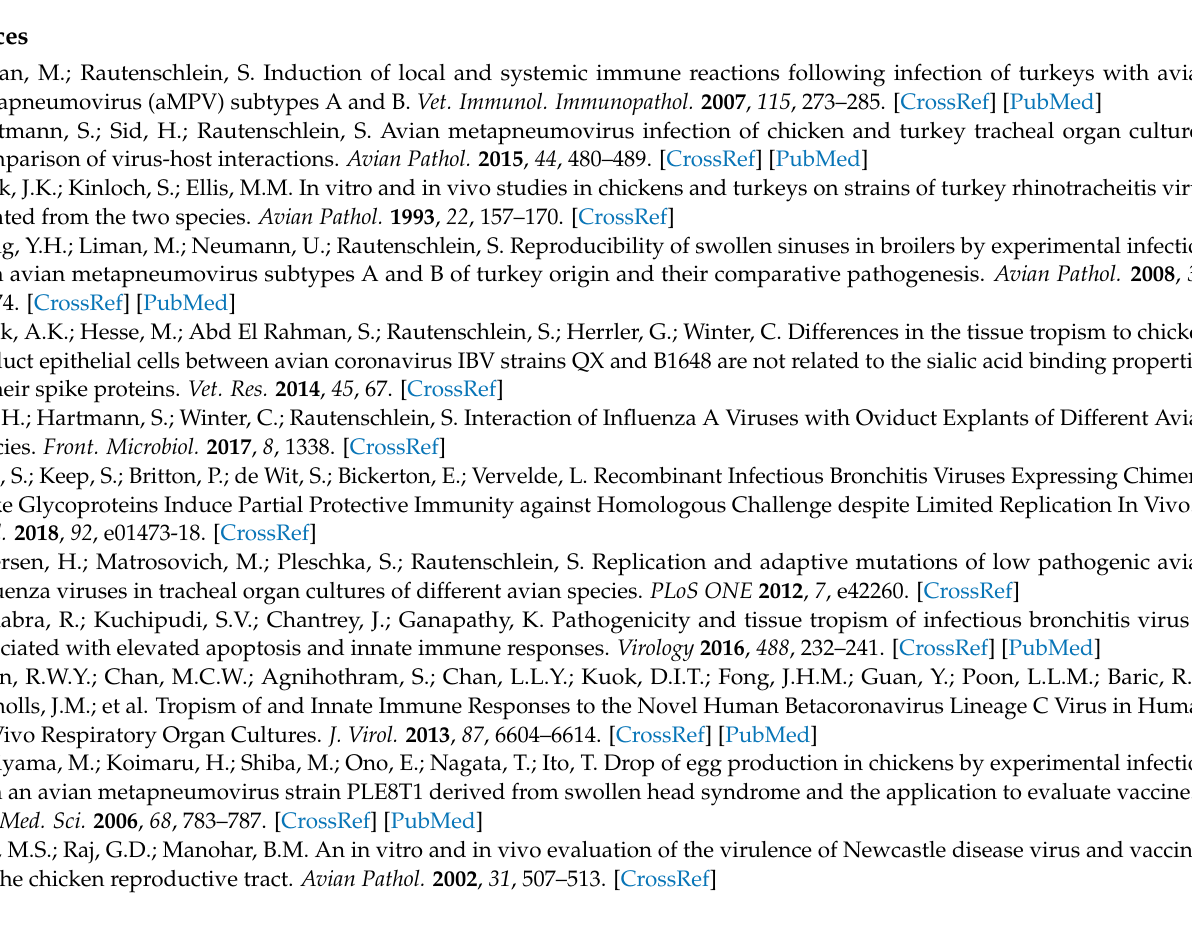
Table S2: Overview of histopathological lesions in TOCs and OOCs separated according to virus strains; Figure S1: Comparative quantification of viral genome by qRT-PCR in TOCs and OOCs after inoculation with AMPV or NDV; Figure S2: mRNA expression of different importin- α isoforms in virus-free TOCs and